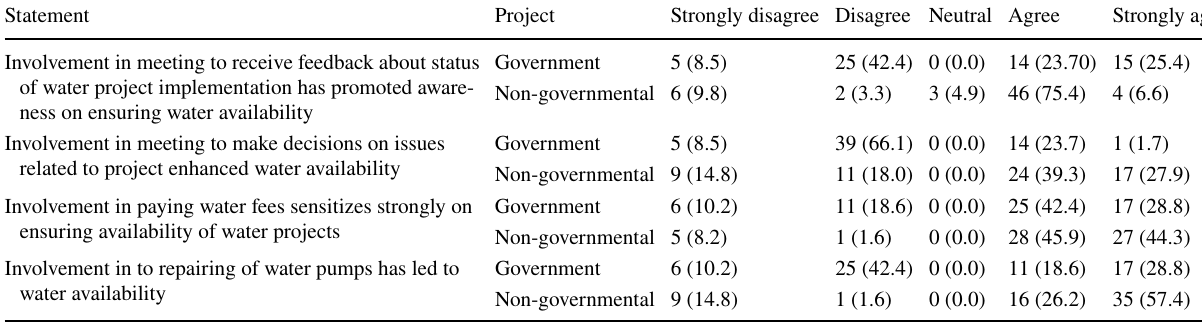
Table 7 Effectiveness of PM&E in ensuring water